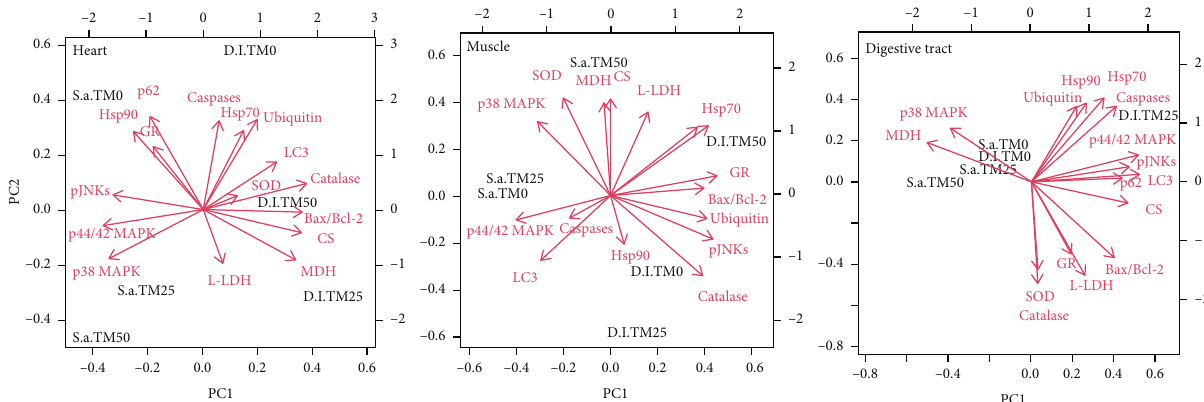
Figure 8: Variable correlations of heart, liver, and digestive tract with each of the fi rst two principal components (PCs) in the multivariate analysis. The PCA was generated from the complete biochemical dataset. Parameters with red vector arrows were included as PCA construction predictors (S.a.: S. aurata ; D.l.: D. labrax